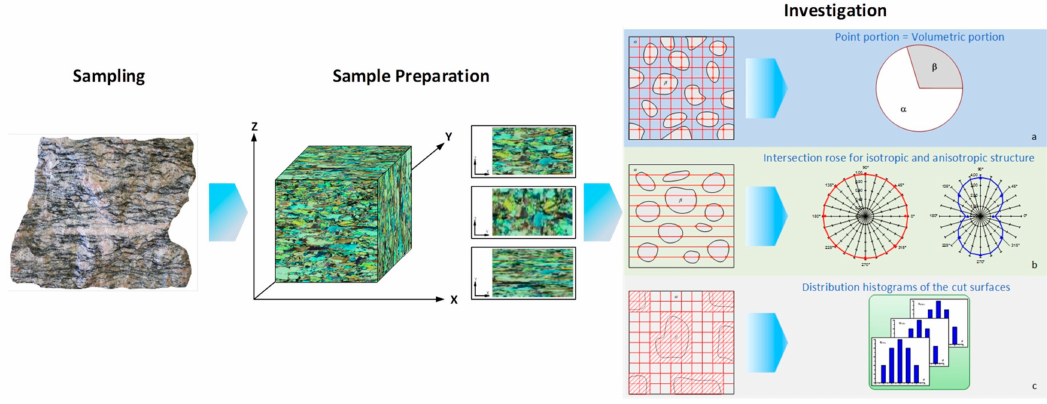
Figure 1. Process flow for QMA rock